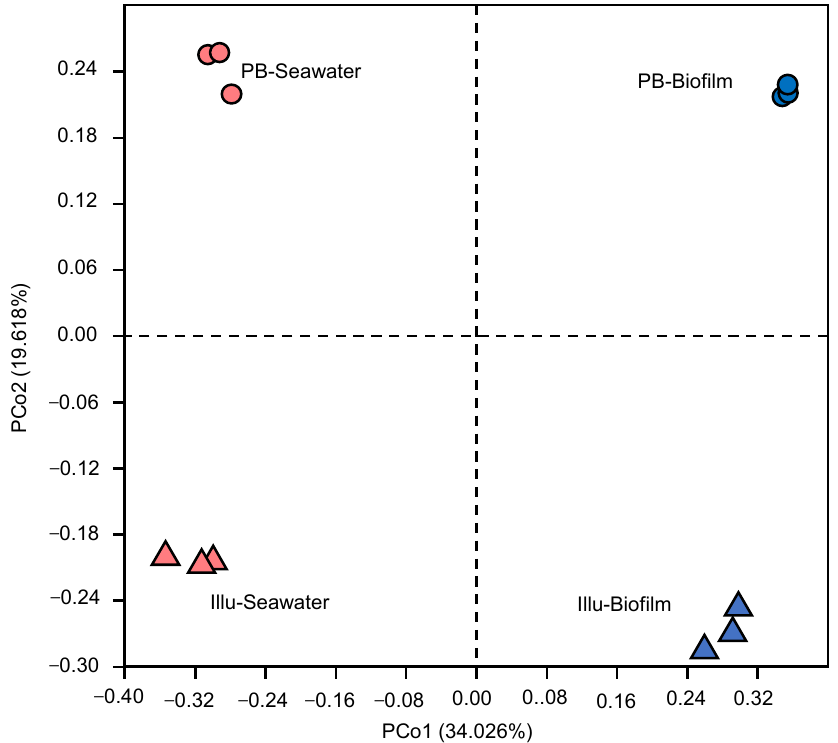
Figure 2. Principal coordinate analysis (PCoA) based on OTU compositions of biofilms and seawater communities. Bray–Curtis distances were used in the calculation. PB-Biofilm and PB-Seawater represent the three biofilm and three seawater samples sequenced by PacBio, respectively. Illu- Biofilm and Illu-Seawater represent the same samples sequenced by